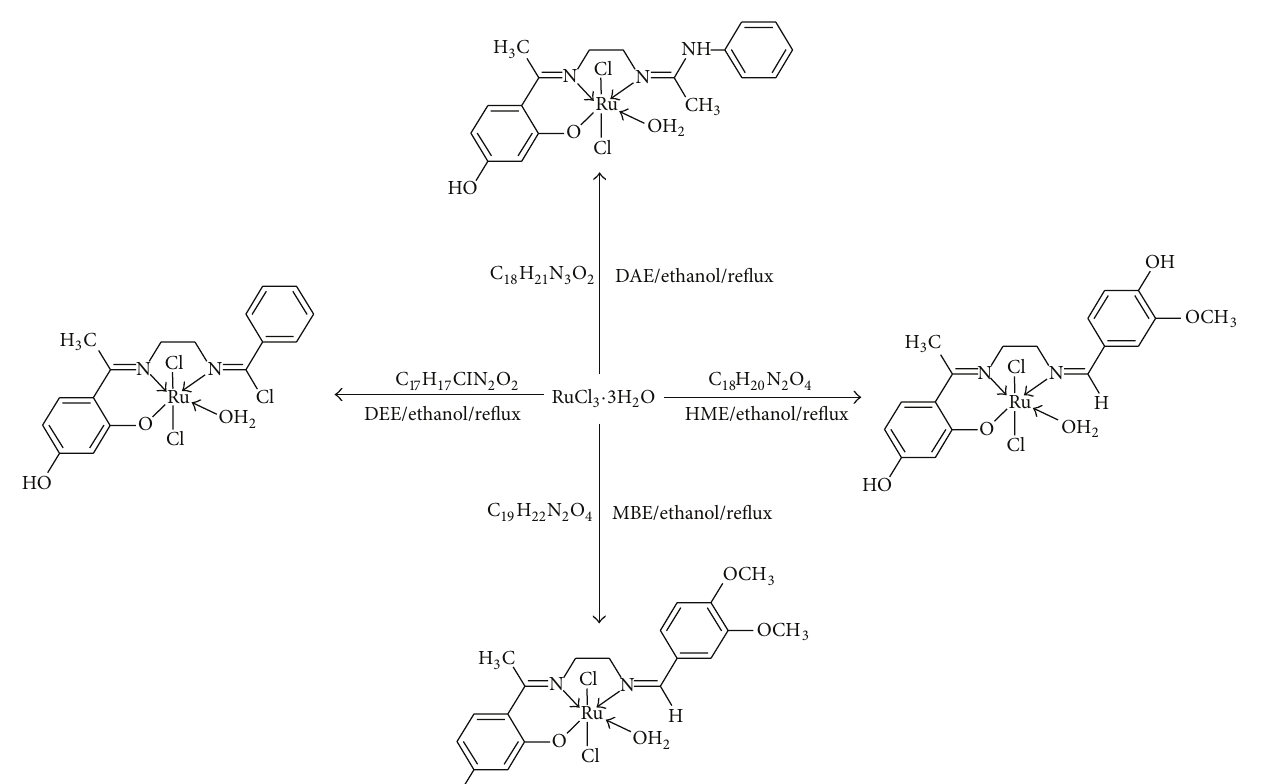
Scheme 1: Structure of mononuclear ruthenium(III)-Schiff base